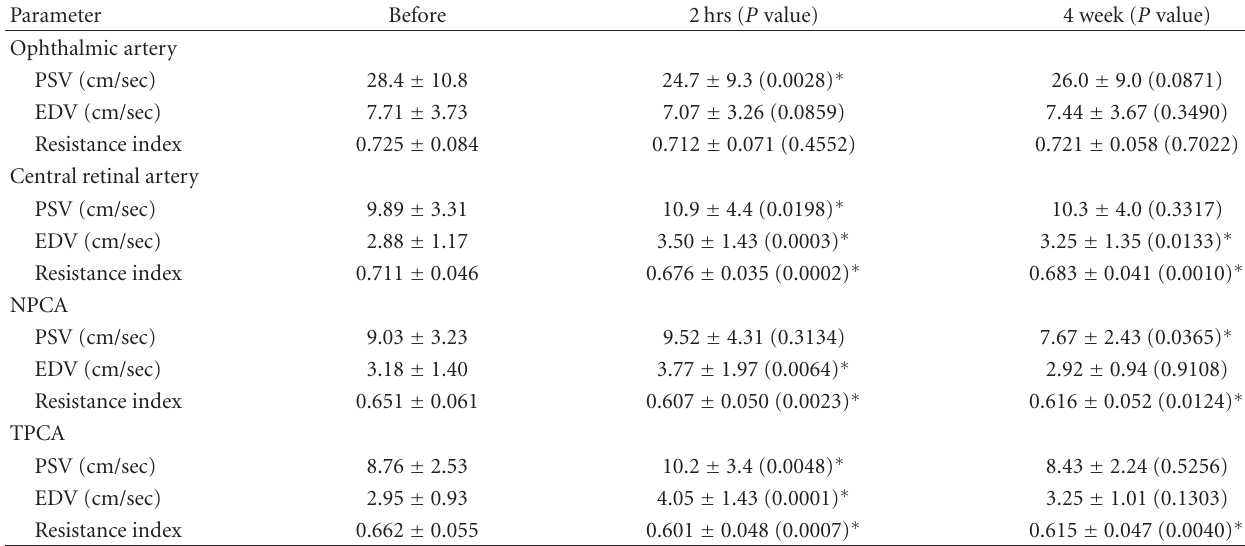
Table 4: Results of color Doppler imaging in normal tension glaucoma with topical nipradilol.